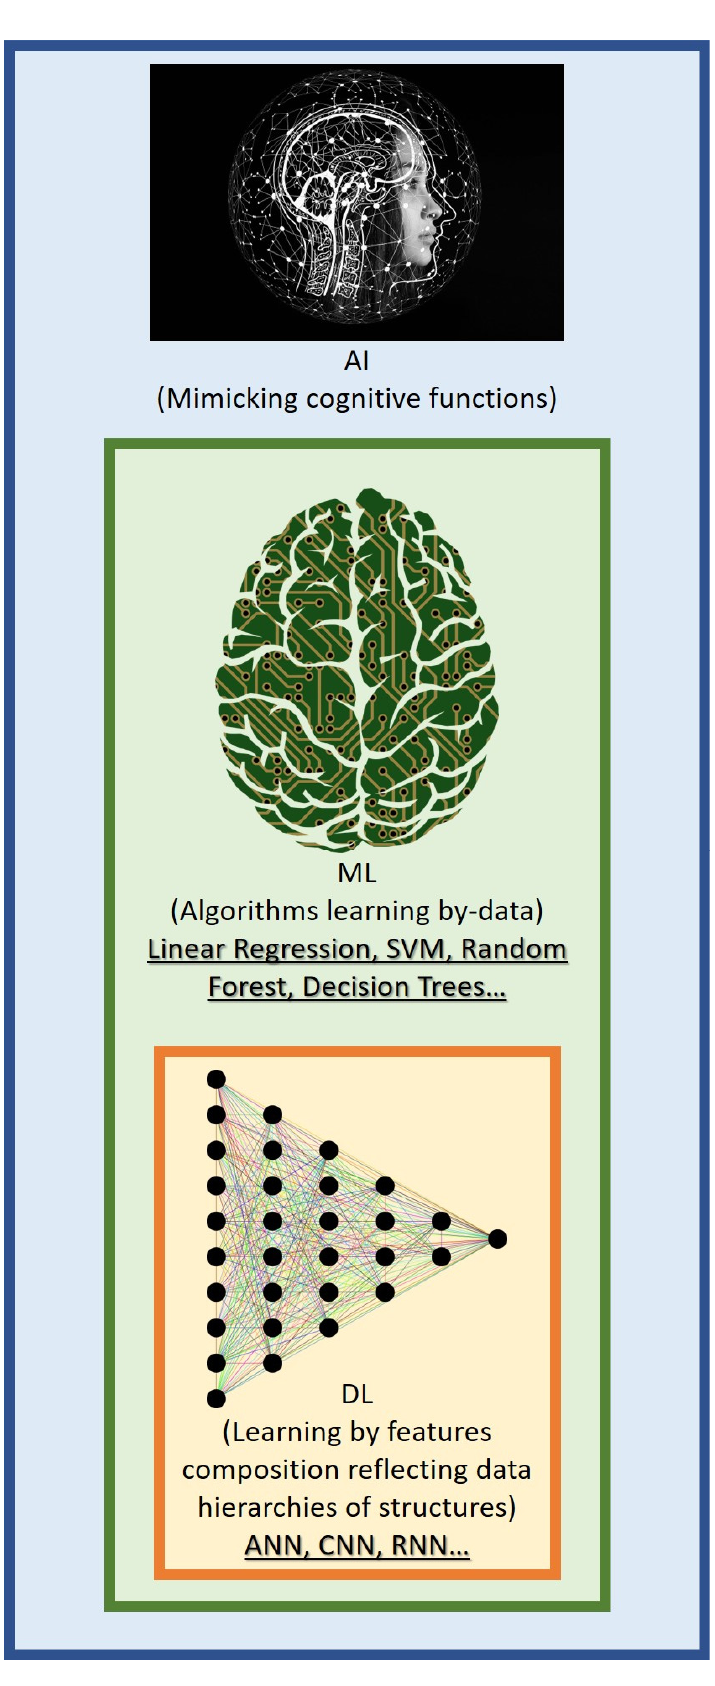
Figure 1. Main AI-based approaches employed in the field of amyloidosis.